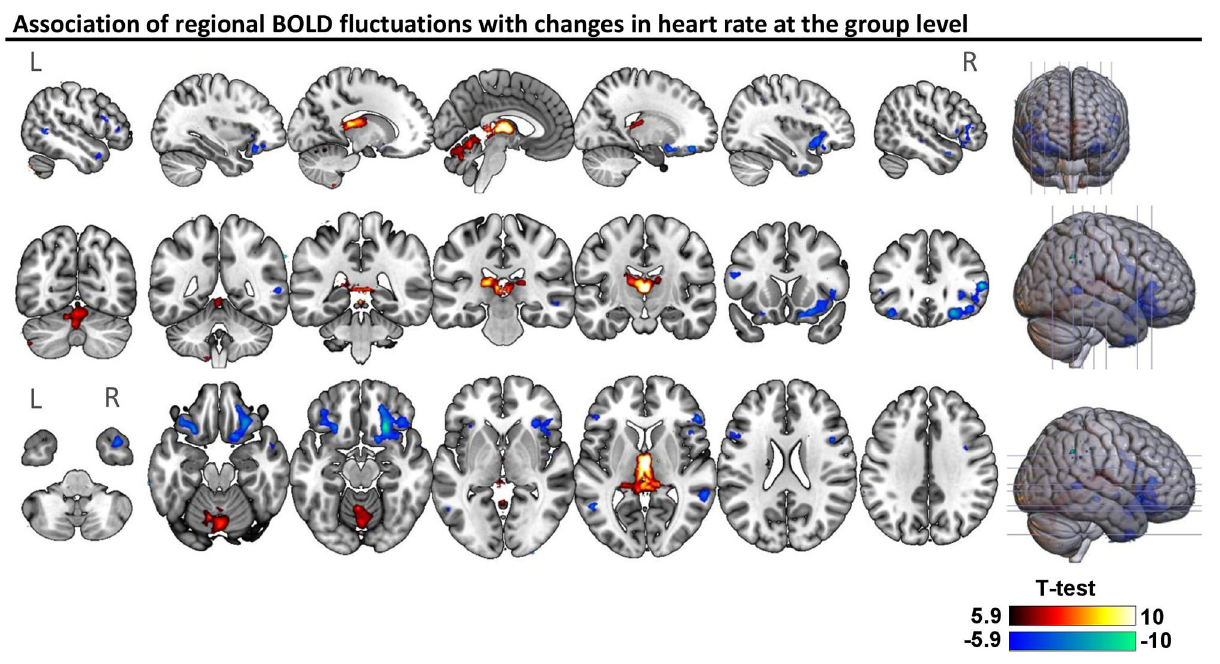
FIGURE 2 | Association of regional BOLD fluctuations with changes in heart rate at the group level. Statistical map of one-sample t -test considering patients and controls ( n = 44), thresholded with a voxel-wise threshold of family-wise error (FWE) rate p < 0.05 corrected for multiple comparisons using the random-field theory (51). The unthresholded statistical map is available at https://neurovault.org/collections/9452/. network and basal ganglia had strong interactions of group and LF-HRV state ( p < 0.0125, FDR corrected; Figure 3 right column). The connectivity between the thalamus and ventral attention network demonstrated also strong interactions of group and RMSSD